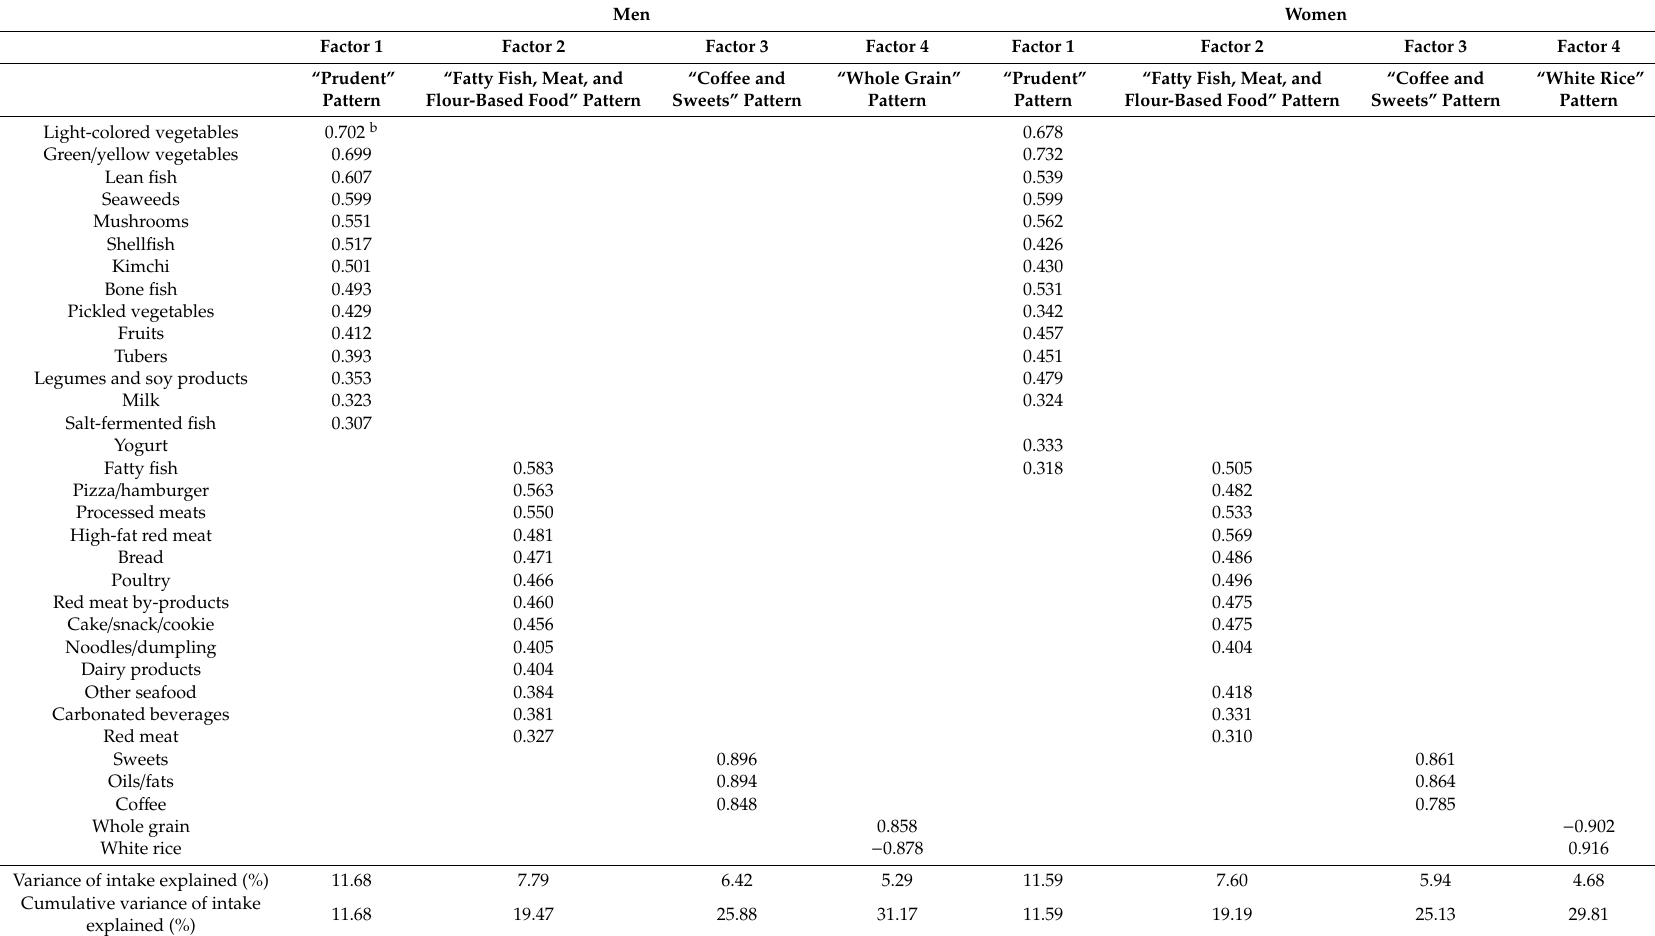
Table 1. Factor loadings for the major dietary patterns identified according to a factor analysis a . Men Women Factor 1 Factor 2 Factor 3 Factor 4 Factor 1 Factor 2 Factor 3 Factor 4 “Prudent” “Fatty Fish, Meat, and “Co ff ee and “Whole Grain” “Prudent” “Fatty Fish, Meat, and “Co ff ee and “White Rice” Pattern Flour-Based Food” Pattern Sweets” Pattern Pattern Pattern Flour-Based Food” Pattern Sweets” Pattern